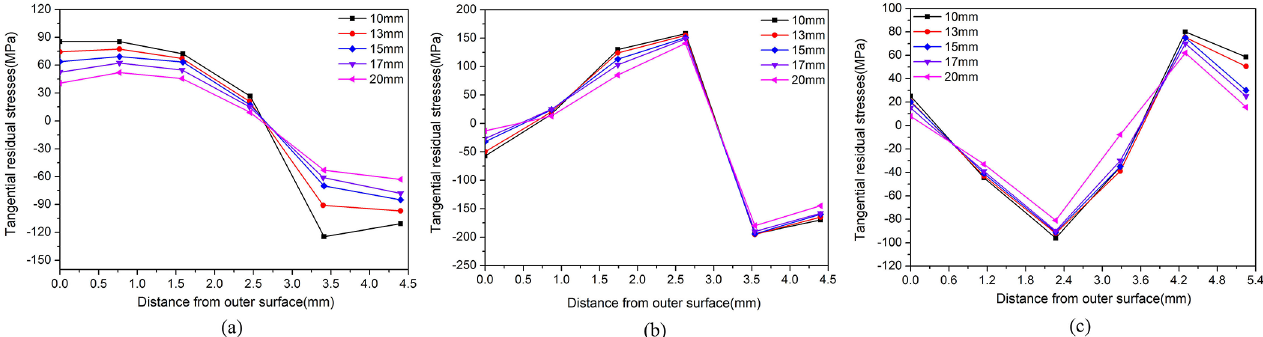
Fig. 12. Tangential residual stress distribution in the (a) cup bottom, (b) cup wall and (c) die entrance radius of square cups under various die corner